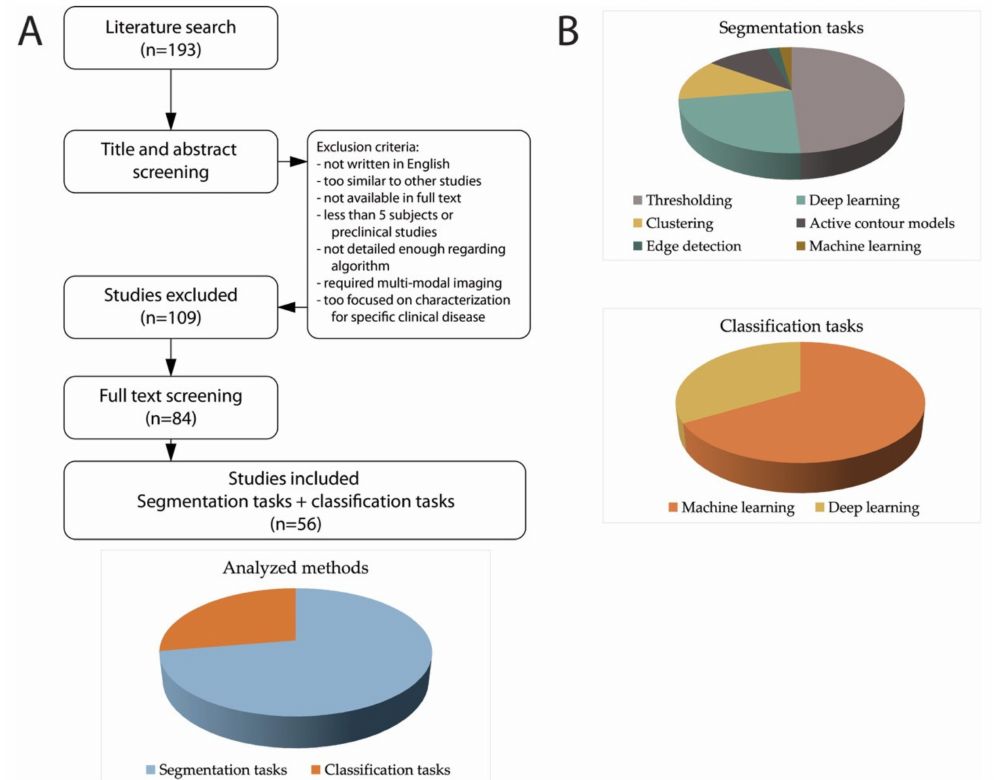
Figure 3. ( A ) Flow chart of study selection. ( B ) Pie charts of segmentation and classification tasks. The methods for segmentation were global or local thresholding (n = 23/47, 48.9%), deep learning (n = 11/47, 23.4%), clustering (n = 6/47, 12.9%), active contour models (n = 5/47, 10.6%), edge detection (n = 1/47, 2.1%), or machine learning (n = 1/47,